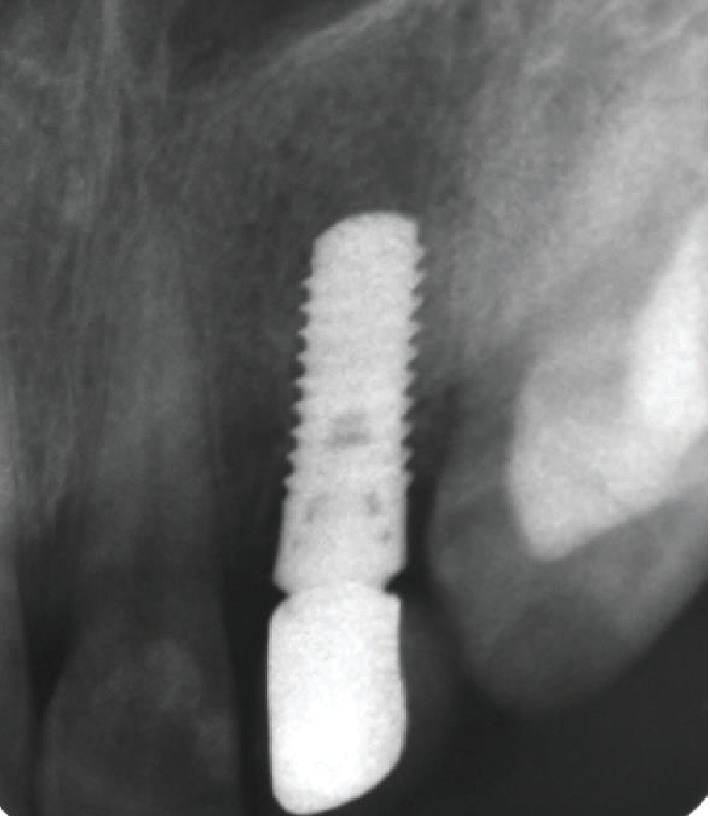
1-year follow-up.